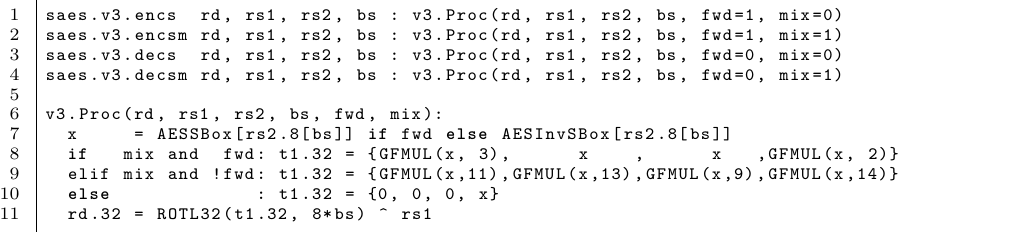
Figure 4: Instruction mnemonics, and their mapping onto pseudo-code functions, for V 3